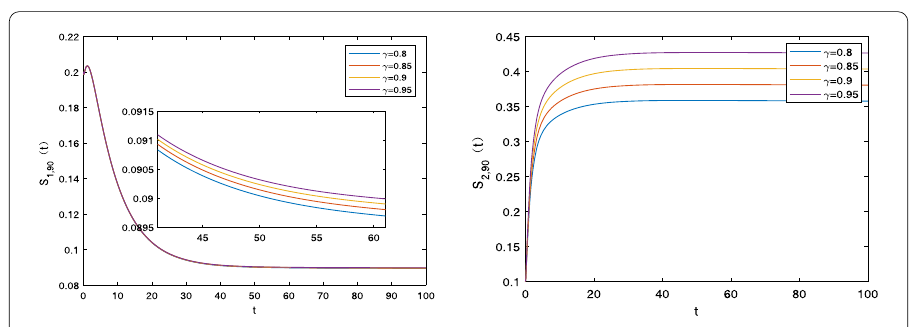
Figure 7 The densities of S 1,90 ( t ) and S 2,90 ( t ) with different values of